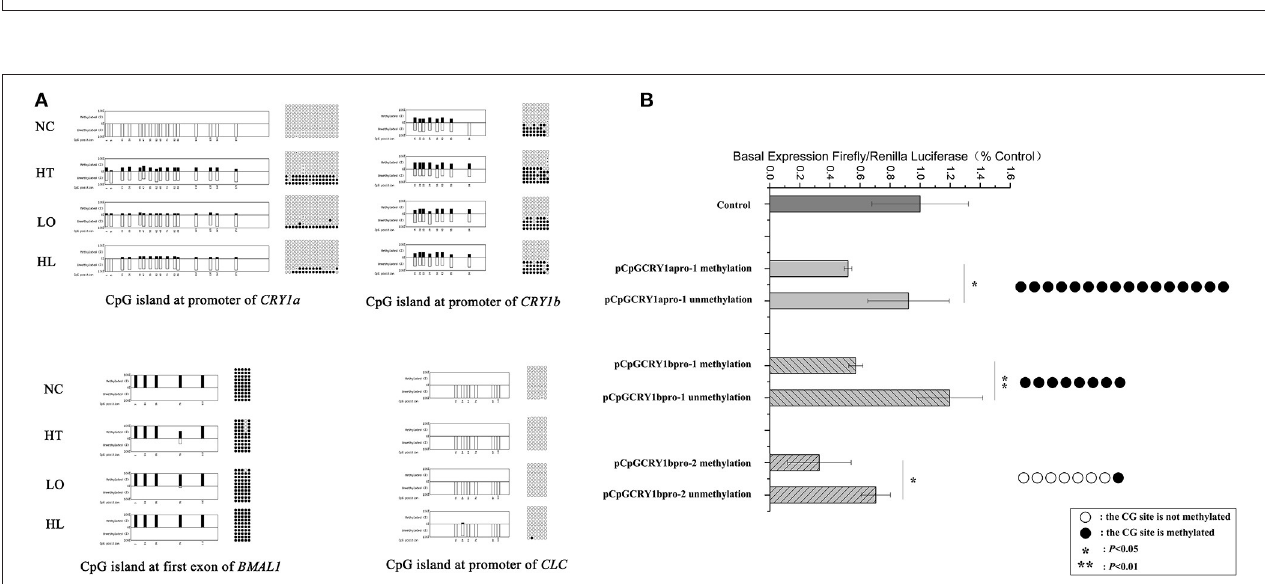
FIGURE 6 | (A) The relative expression of genes of circadian rhythm under heat stress, hypoxia stress, and heat–hypoxia stress. (B) The relative expression of CRY1a and CRY1b after interference and relative activity of PK and ATPase under heat stress, hypoxia stress, and heat–hypoxia stress for 24h and the interference groups of dsRNA CRY1a and dsRNA CRY1b under heat stress, hypoxia stress, and heat–hypoxia stress for 24h.